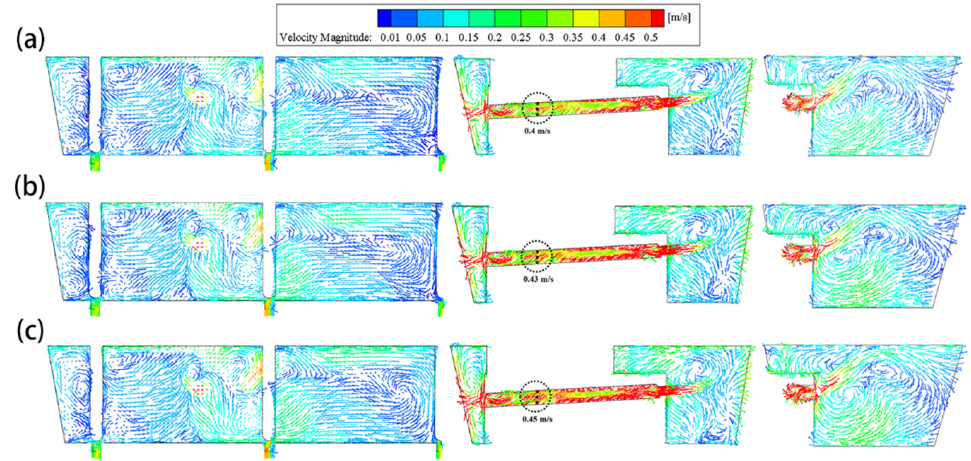
Figure 22. Velocity vector in the vertical planes passing through the center of all outlets(left), main channel (middle) and port (right) for case FK-A0 under different heating power: ( a ) 800 kW; ( b ) 1000 kW; ( c ) 1200 kW.